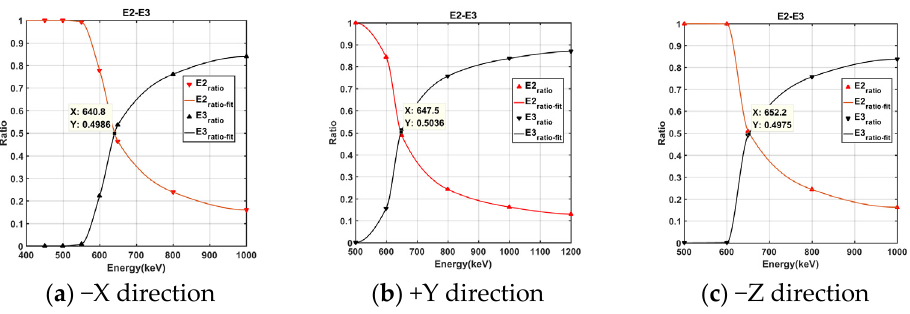
Figure 16. Calibration results of the electron energy channel in three directions (650 keV).